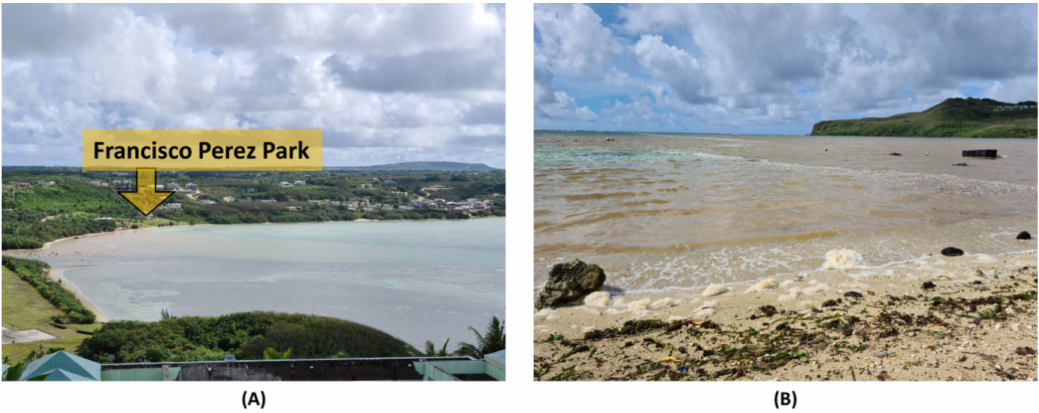
Figure 5. Photos from Pago Bay Outlook ( A ) and Francisco Perez Park ( B ) on 23 June 2021, the day after Tropical Depression 06W made landfall on